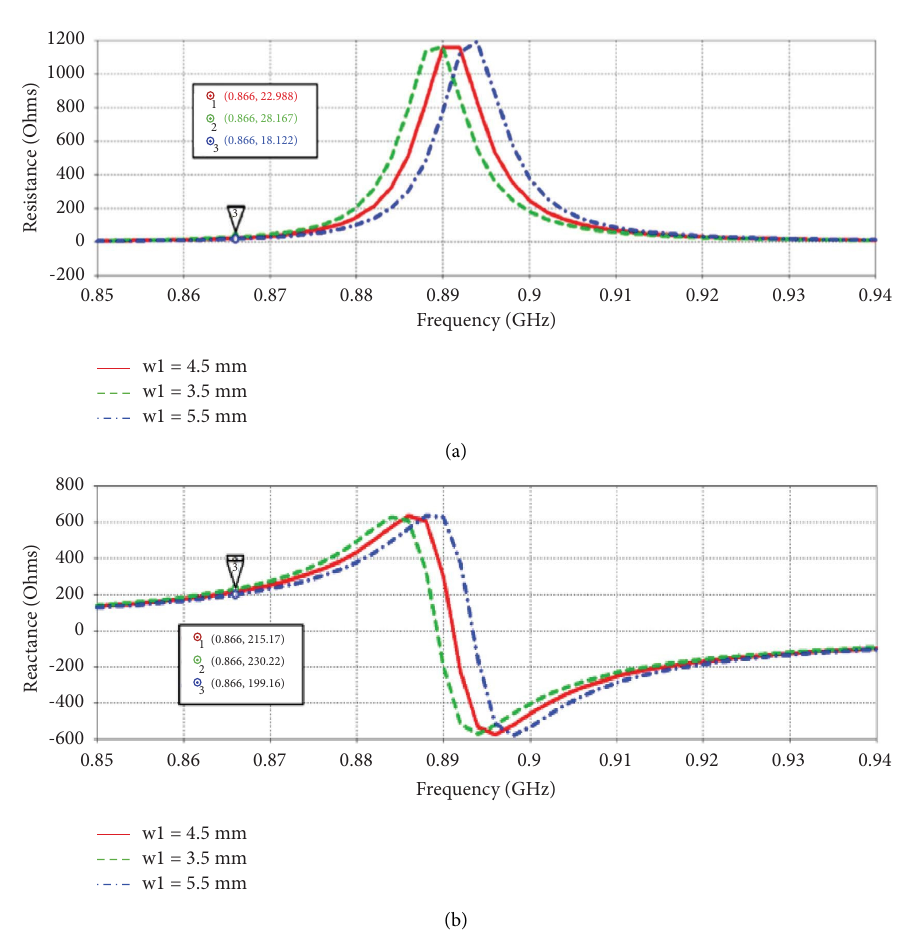
Figure 7: Tag’s (a) resistance and (b) reactance variation with varying “ w